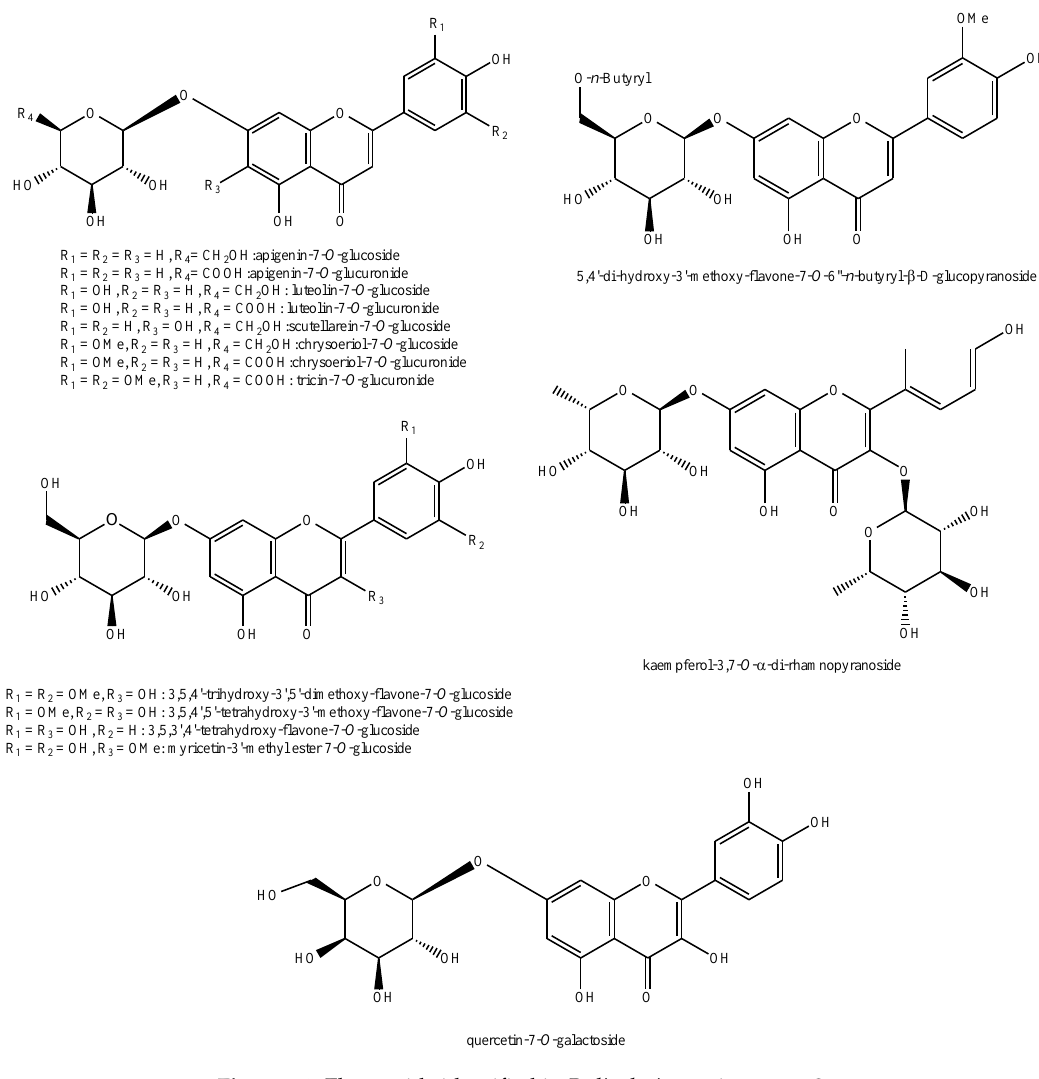
Figure 14. Flavonoids identified in Pedicularis species—part 2.